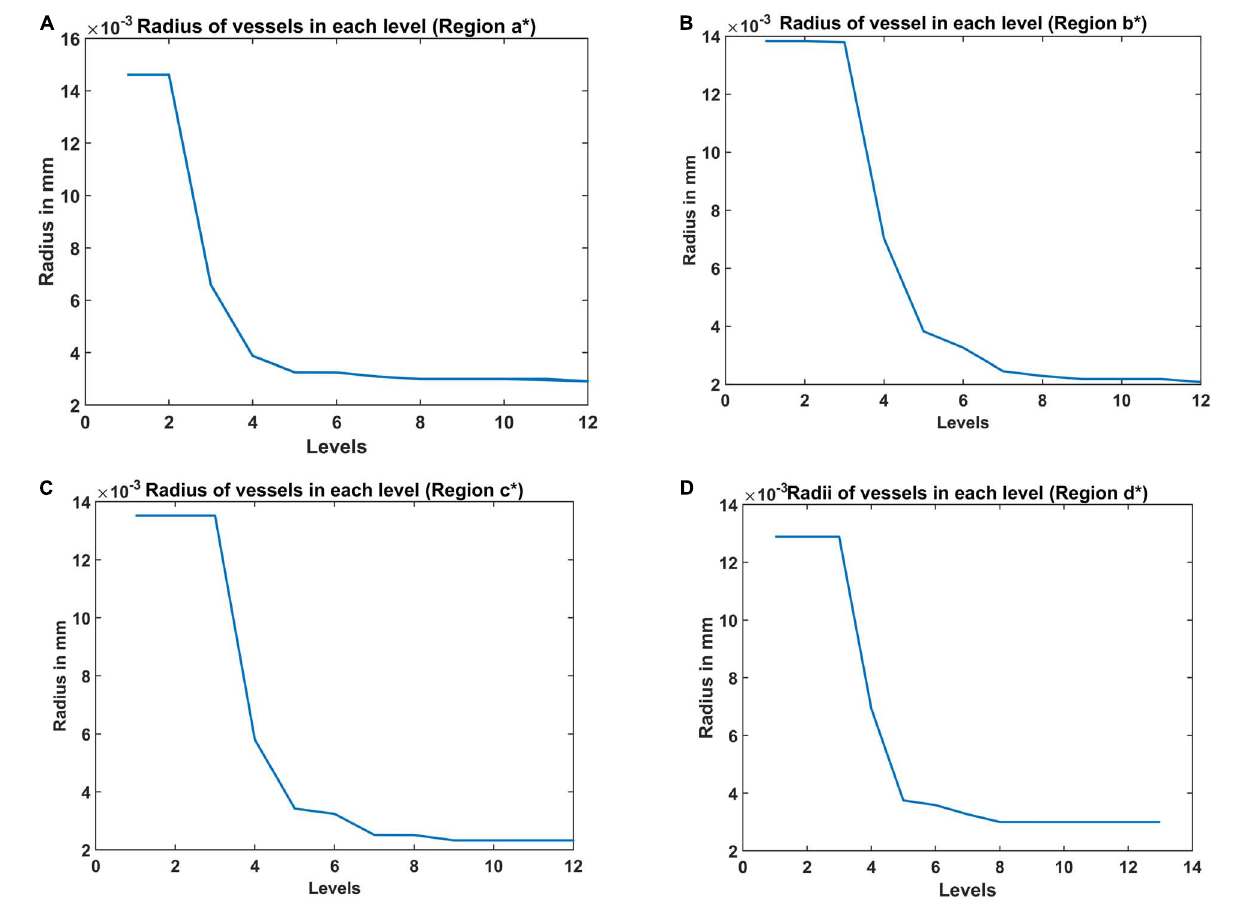
FIGURE 6 | The radii at each level estimated from the A-VAM study for the following four regions: (A) agranular cortex which was measured 1 mm anteroposterior and 1 mm mediolateral of the Bregma, (B) partially granular cortex measured –1 mm anteroposterior and 1 mm mediolateral of the Bregma, (C) partially granular cortex measured 2 mm anteroposterior and 1 mm mediolateral of the Bregma, and (D) granular cortex measured 1 mm anteroposterior and 4 mm mediolateral of the Bregma. (* indicates the region of the cortex considered – please see Figure 10 in Tsai et al.,